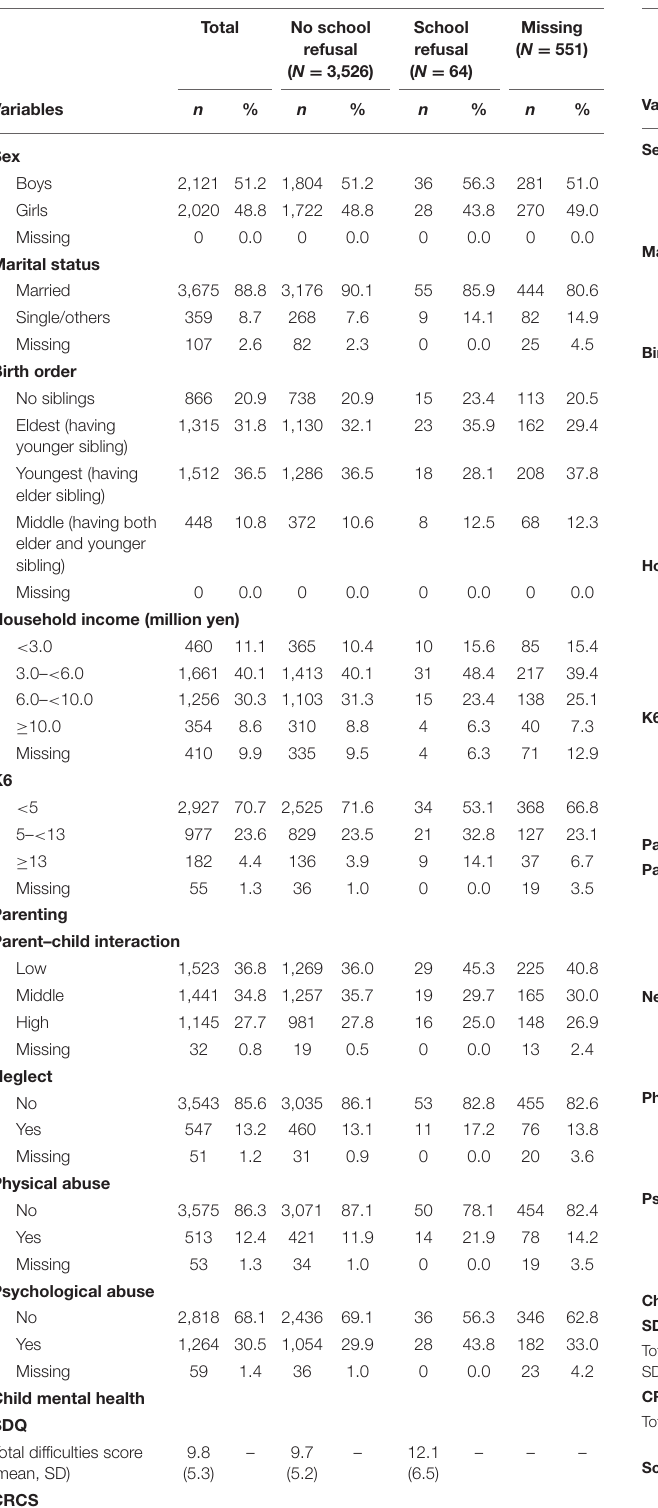
TABLE 1 | Demographic characteristics of the participants in the first grade by school refusal status in the second grade ( N = 4,141).